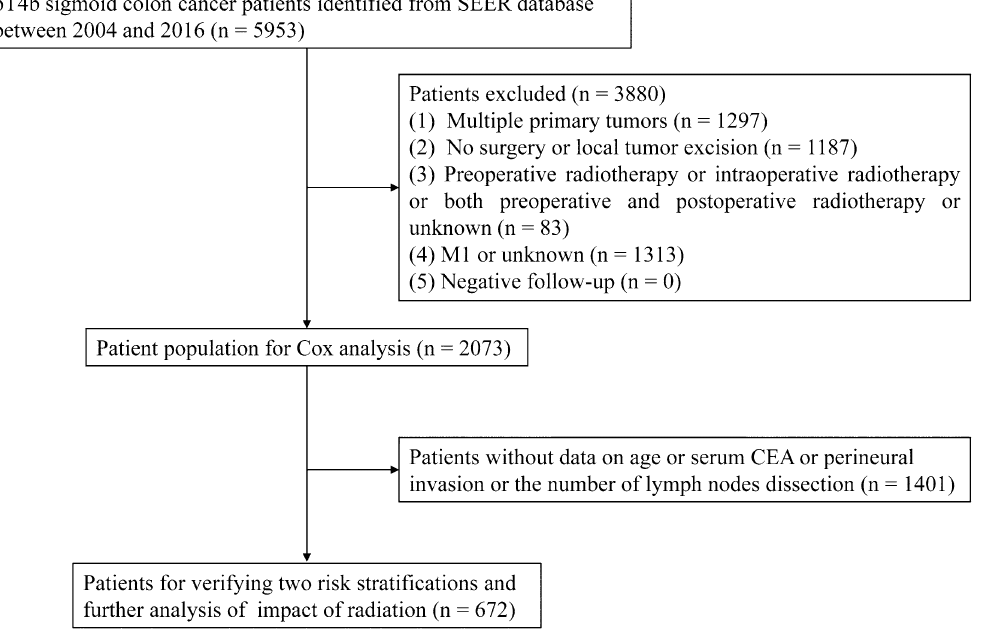
Figure 1. Flow chart of the search protocol and study